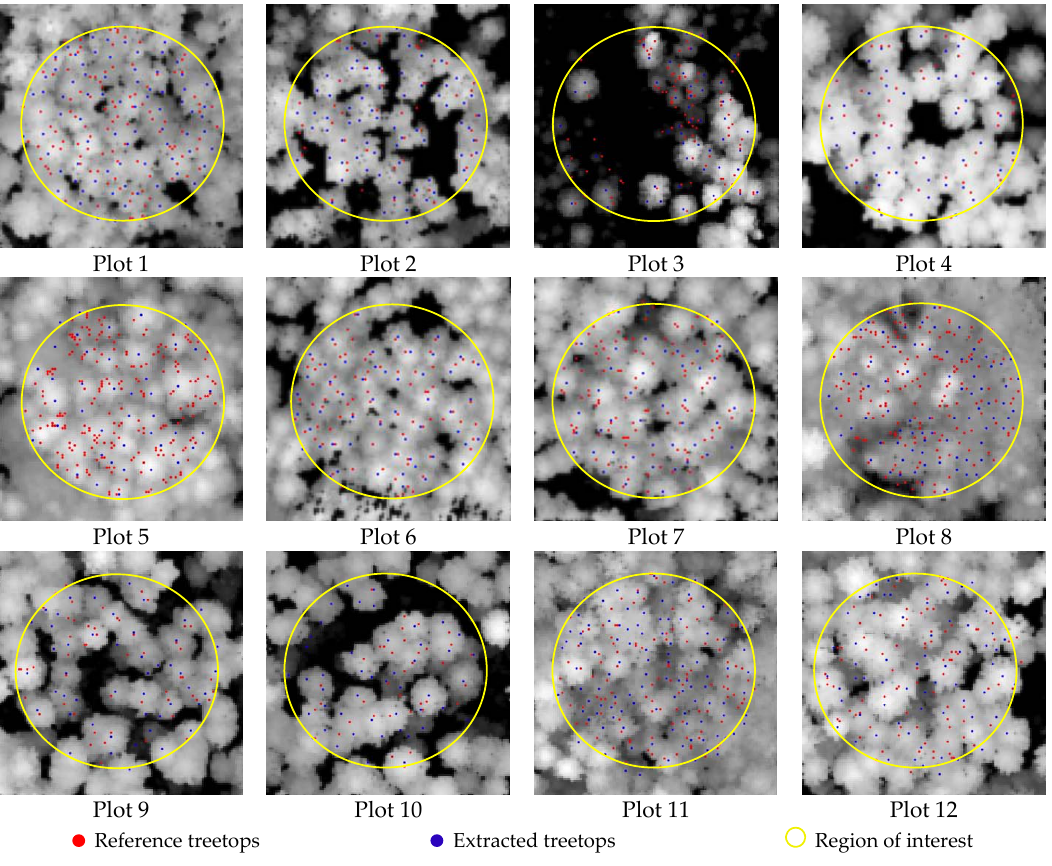
Figure 9. Results for each plot of the dataset.